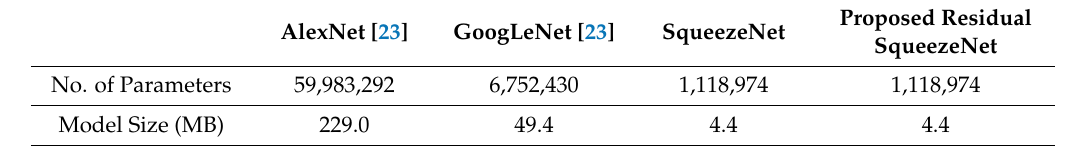
Table 4. Model size and number of parameters.